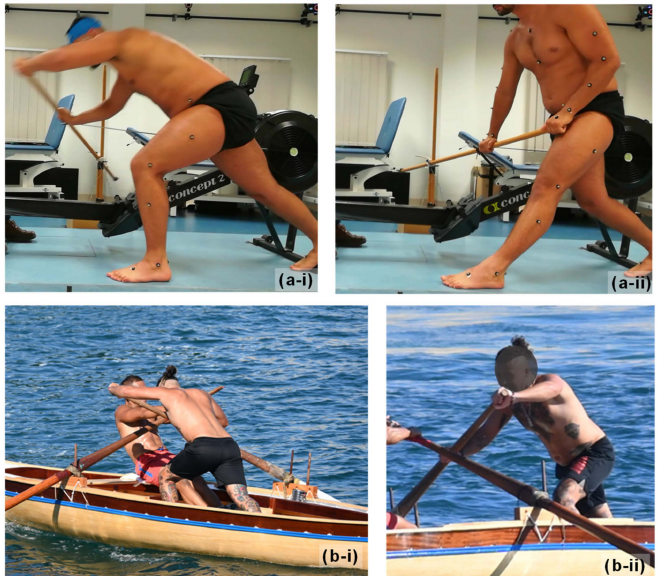
Figure 2. ( a ) The set up used in the laboratory to mimic the on-water setup, shown in ( b ). Note that the rowers in ( a-i ) and ( b ) are nearing to the “finish” whilst the rower in ( a-ii ) is nearing the “catch”. Note also the position of the reflective markers, shown more clearly in ( a-ii